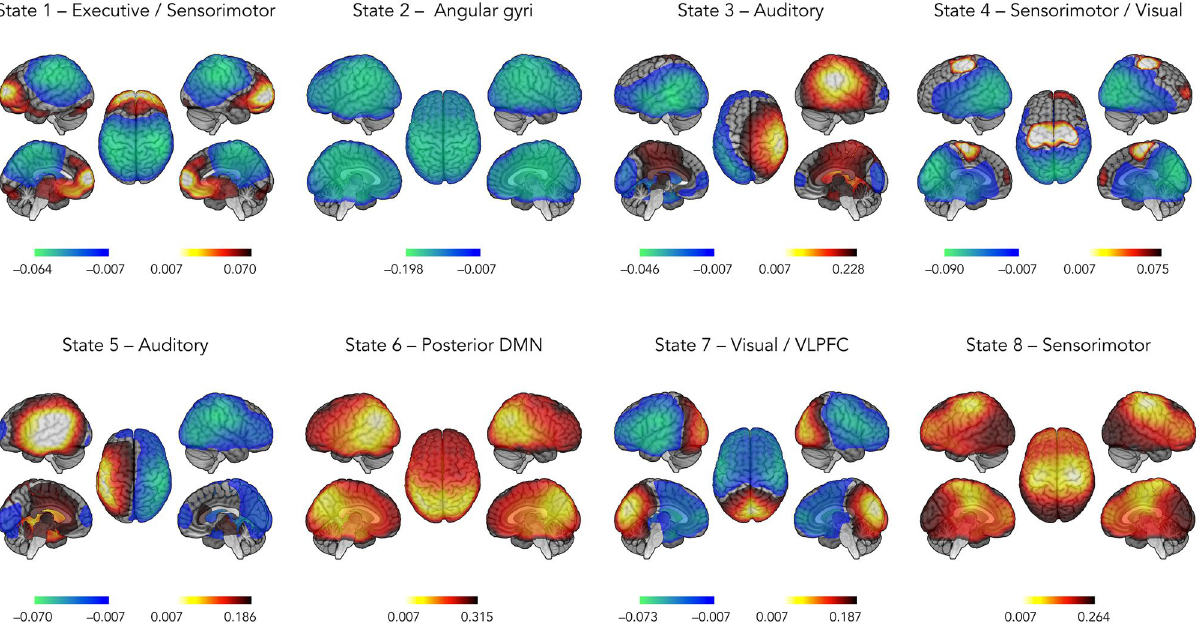
Figure 1. State power topography of the 8 HMM transient states. The red scale indicates positive correlation values between the envelope and the state time course (i.e., a power increase while visiting that state), whereas the blue scale indicates negative correlation values (i.e., a power decrease). DMN default-mode network, VLPFC ventrolateral prefrontal